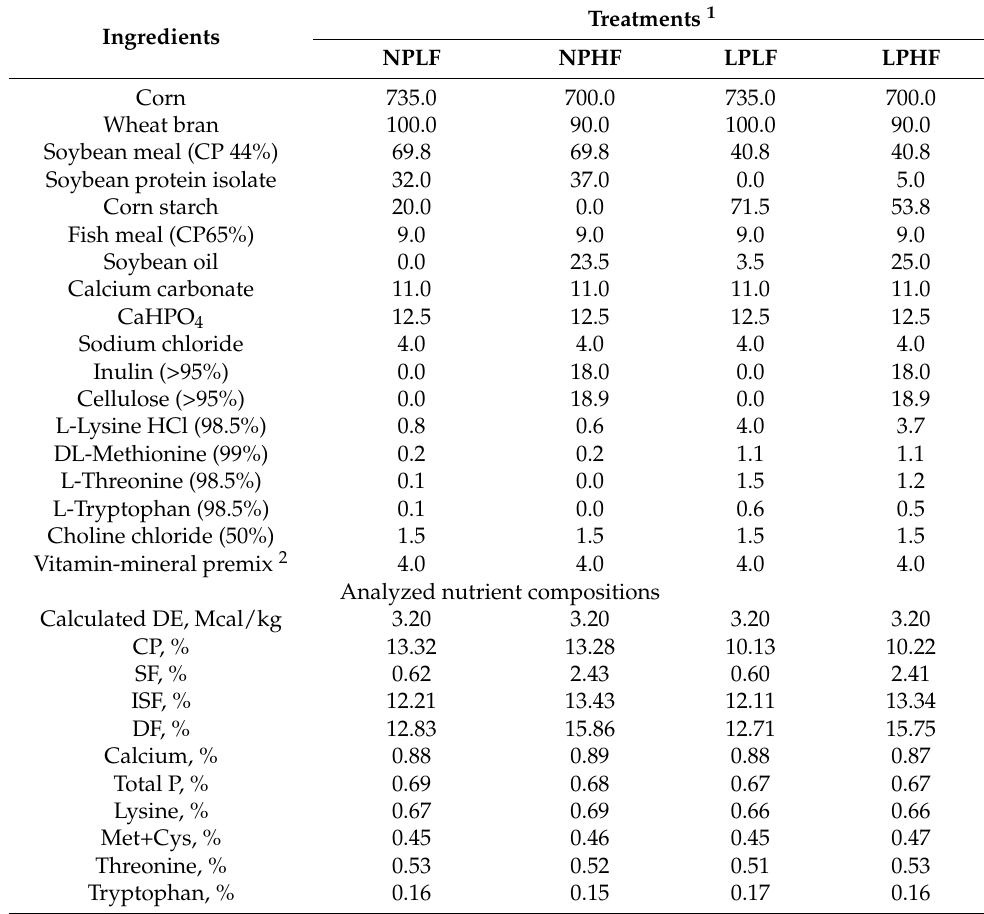
Table 1. Diet composition and nutrient